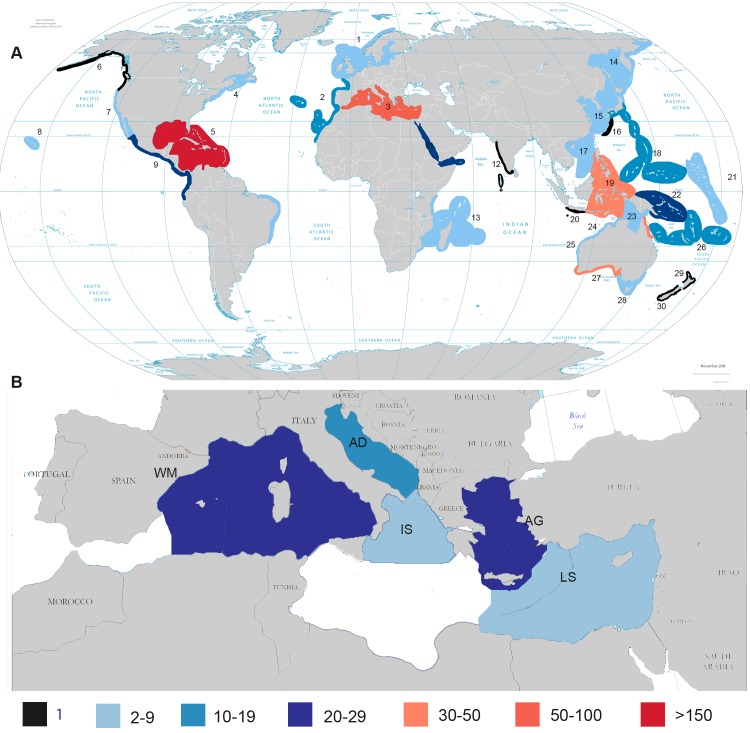
Regional pattern of records of sponge-cyanobacteria associations.Provinces in A and ecoregions in B are according to Spalding et al. [48]: 1, Northern European Seas; 2, Lusitanian; 3, Mediterranean Sea; 4, Cold Temperate Northwest Atlantic; 5, Tropical Northwestern Atlantic; 6, Cold Temperate Northeast Pacific; 7, Warm Temperate Northeast Pacific; 8, Hawaii; 9, Tropical East Pacific; 10, Tropical Southwestern Atlantic; 11, Red Sea and Gulf of Aden; 12, Central Indian Ocean Islands; 13, Western Indian Ocean; 14, Cold Temperate Northwest Pacific; 15, Warm Temperate Northwest Pacific; 16, South Kuroshio; 17, South China Sea; 18, Tropical Northwestern Pacific; 19, Western Coral Triangle; 20, Java Transitional; 21, Marshall, Gilbert, and Ellis Islands; 22, Eastern Coral Triangle; 23, Sahul Shelf; 24, Northwest Australian Shelf; 25, West Central Australian Shelf; 26, Tropical Southwestern Pacific; 27, Southwest Australian Shelf; 28, Southeast Australian Shelf; 29, Southern New Zealand; 30. Northern New Zealand; WM, Western Mediterranean; AD, Adriatic Sea; IS, Ionian Sea; AG, Aegean Sea; LS, Levantine Sea.